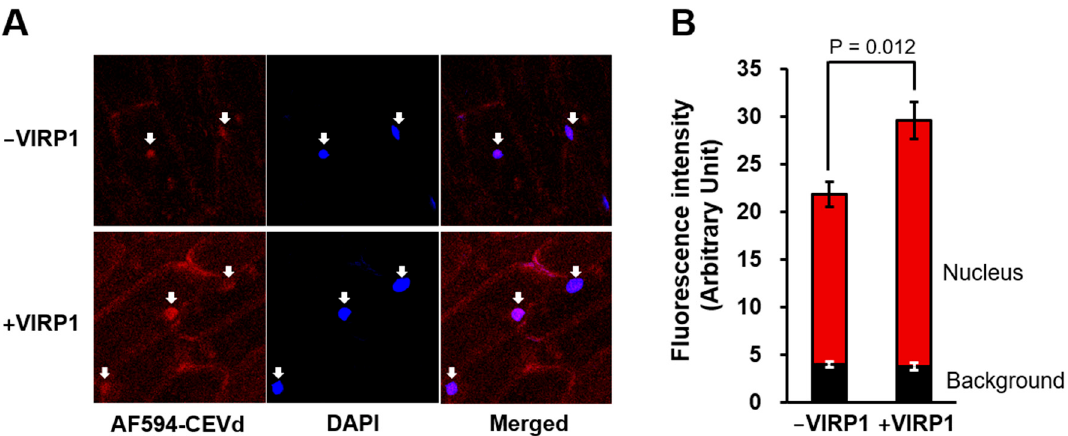
Figure 3. Nuclear import of Alexa Fluor-594-labeld CEVd (AF594-CEVd) and influence of VIRP1 on nuclear import of CEVd. ( A ) Fluorescence images of AF594-CEVd in absence or presence of VIRP1. Arrows indicate the location of nuclei. ( B ) Quantitatively measured nuclear accumulation of AF594-CEVd. Vertical bars indicate the standard errors of four in- dependent experiments. Statistical significance was examined by the Student’s T-test.